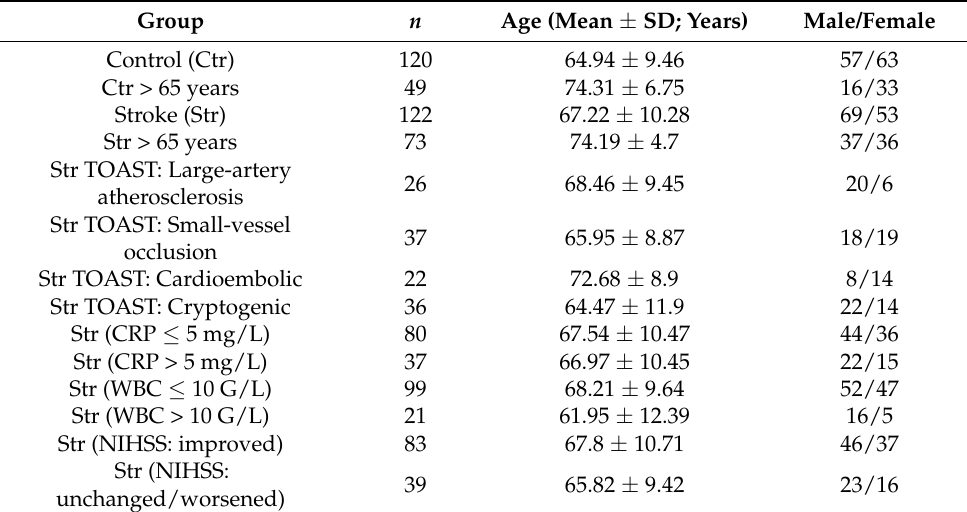
Table 1. Demographic data of members of the genotyping study